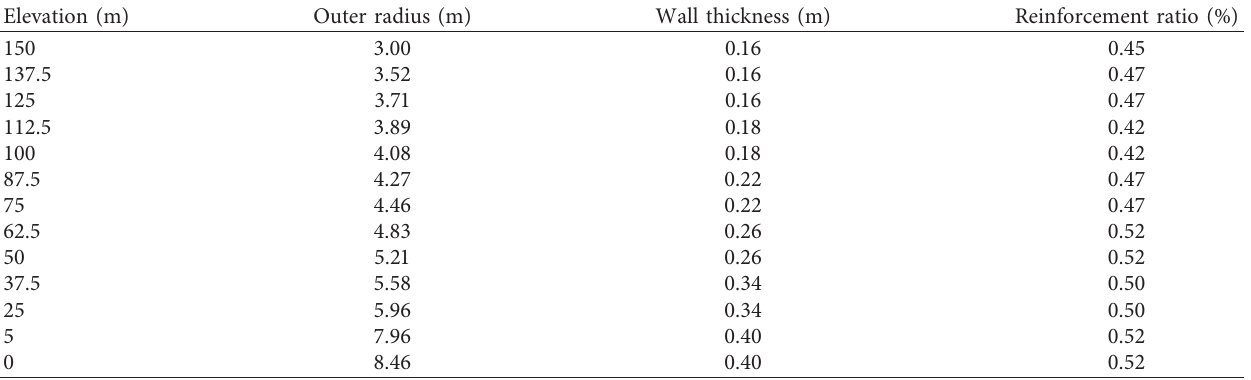
Table 2: Parameters of 150m high RC chimney.